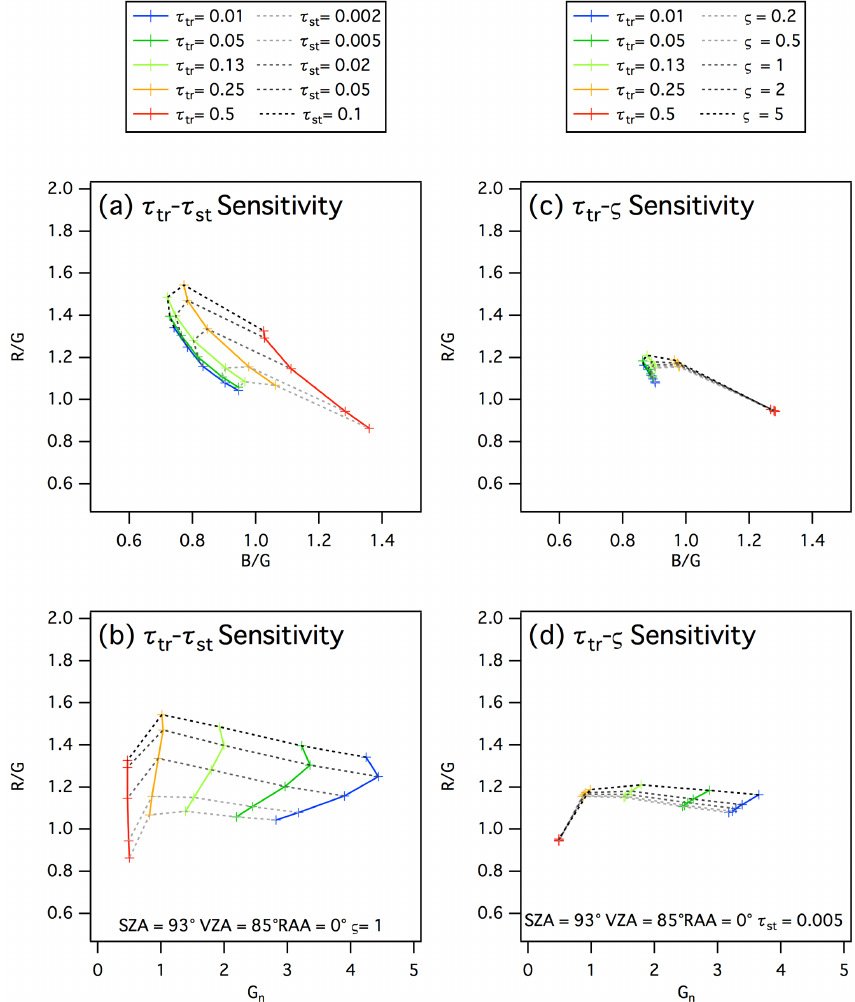
Figure 5. Sensitivity test results for color ratio values of the twilight glow (VZA of 85 ◦ and SZA of 93 ◦ at the solar azimuth angle). (a, b) show the he dependence of color ratio variations on the R / G–B / G cross section; (c, d) show the dependence of normalized brightness variations on the R / G– G n cross section. Dashed curves in the panels on the right (b, d) are isolines of coarse–fine particle volume ratio, and solid curves are isolines of tropospheric aerosol optical thickness. Dashed curves in the panels on the left (a, c) are isolines of stratospheric aerosol optical thickness, and solid curves are isolines of tropospheric aerosol optical